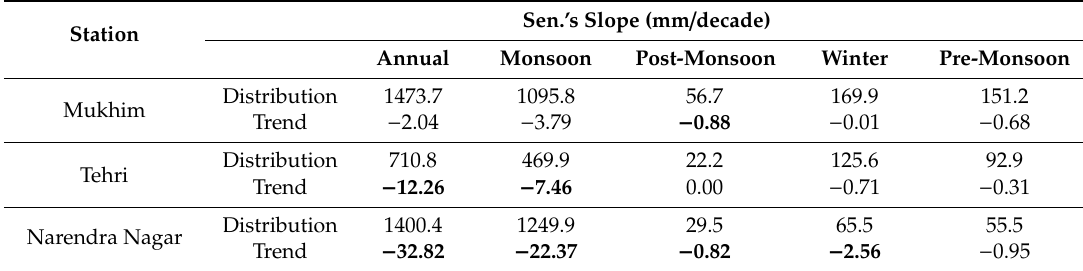
Figure 4. ( a – c ) are showing the relationship between the gridded and observed datasets (r 2 ), ( d ) Bias, ( e ) RMSE and ( f ) CDF for all datasets with the corresponding station for the period from 1983 to 2008. Table 4. Annual and seasonal rainfall distributions and trends (1983–2008) in the Bhilangana river basin for ground station